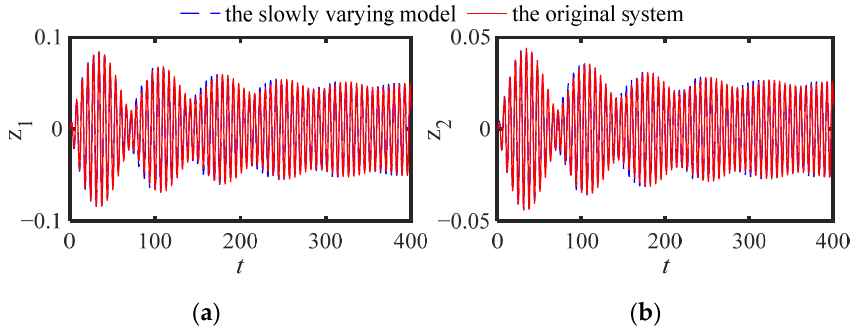
Figure 2. Displacement responses: ( a ) main structure, ( b ) NES ( ε 1 = 0).